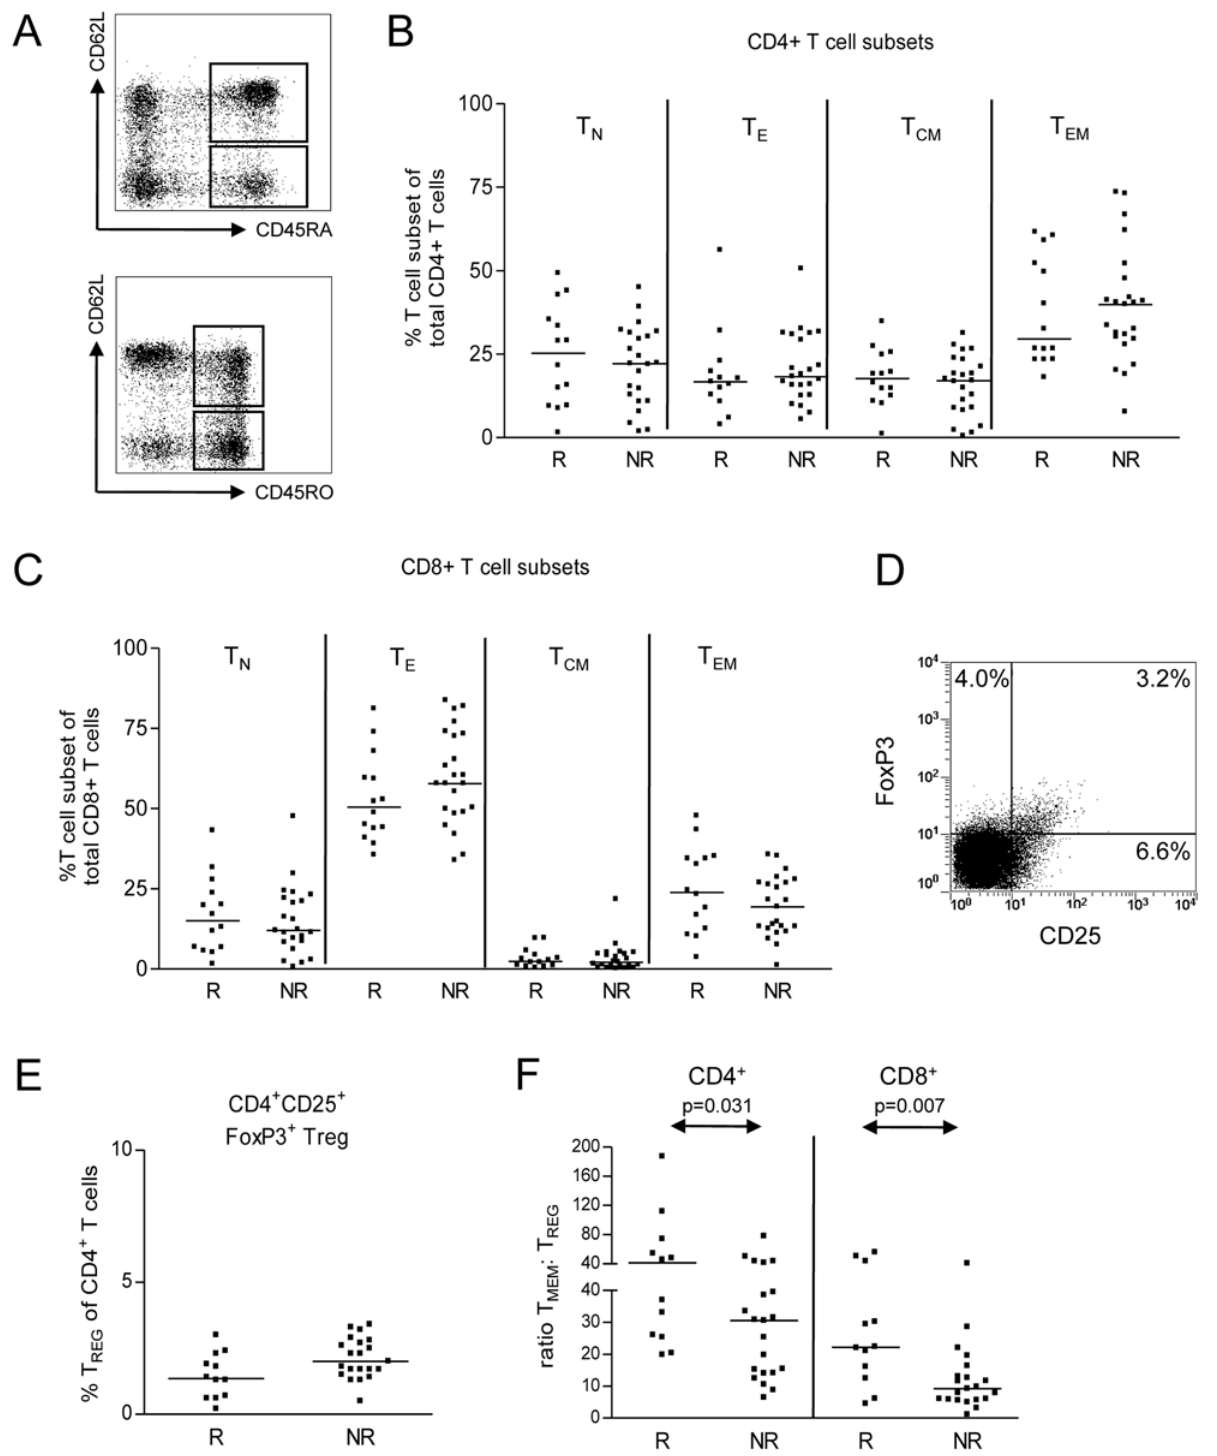
Figure 1. The frequency of effector, memory and regulatory T cell subsets in the peripheral blood of renal transplant patients immediately before the start of tacrolimus dose reduction (T1). (A) Representative dot plots of CD62L versus CD45RA and CD62L versus CD45RO. The analysis was performed on cells within the lymphocyte gate in the forward/side scatter plot. (B) The percentage of naı¨ve (T N , CD45RA + CD62L + ), effector (T E , CD45RA + CD62L-), central memory (T CM , CD45RO + CD62L + ) and effector memory (T EM , CD45RO + CD62L-) T cells within the total CD4 + T cell subset. R vs. NR=not significant. (C) As described under A, for CD8 + T cells. R vs. NR=not significant. (D) Representative dot plot of CD25 versus FoxP3 in CD4 + lymphocytes. (E) The percentage of CD25 + FoxP3 + regulatory T cells (Treg) within CD4 + lymphocytes. R vs. NR=not significant. (F) The ratio between the percentage of memory T cells and the percentage of Treg.